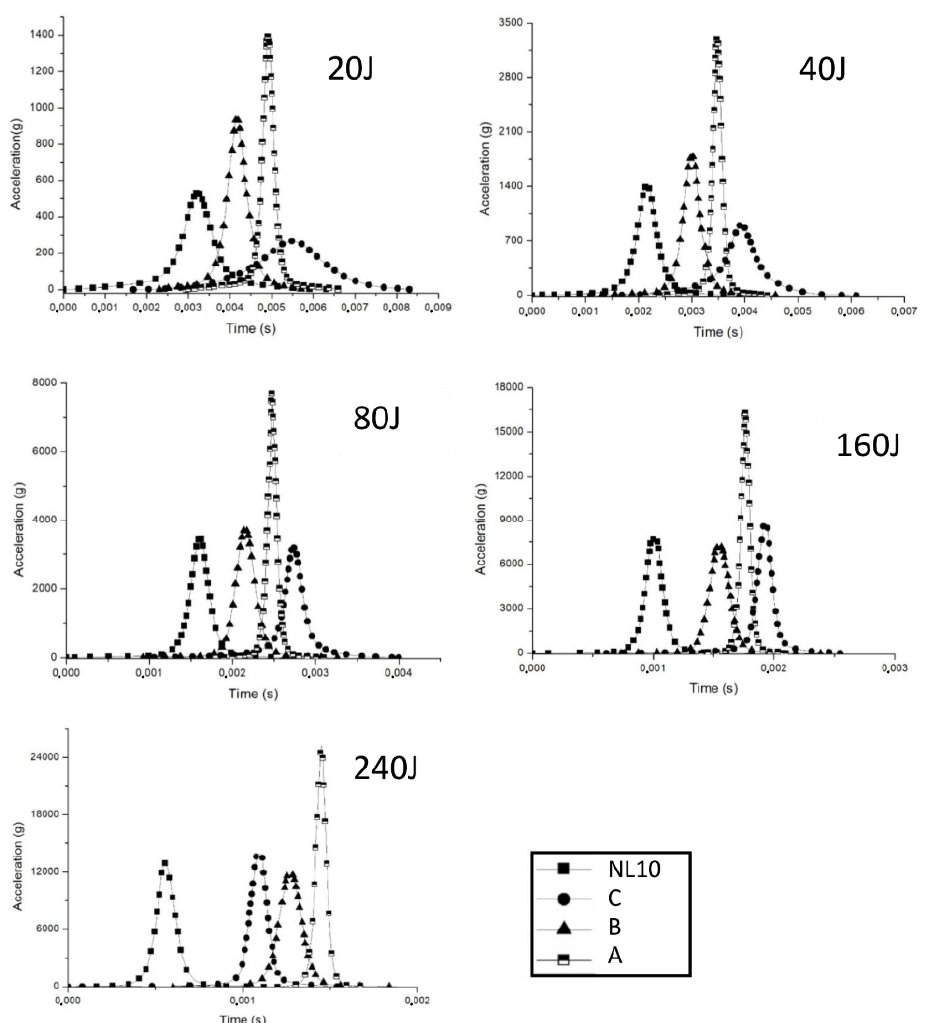
Figure 8. Acceleration impact test results for headbands produced with three commercial solutions A (64.90 kg/m 3 ), B (309 kg/m 3 ), C (218 kg/m 3 ) and an agglomerated cork of 140 kg/m 3 density (Reprinted with permission from [66]).